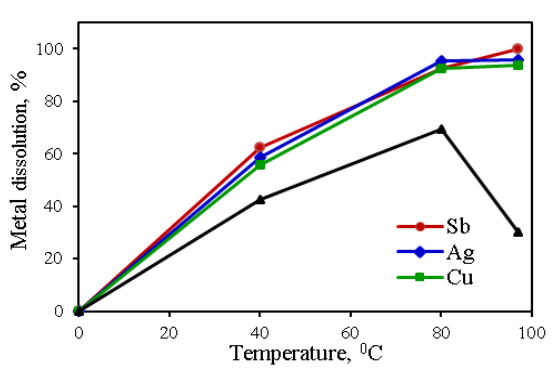
Fig. 6. Influence of reaction temperature on